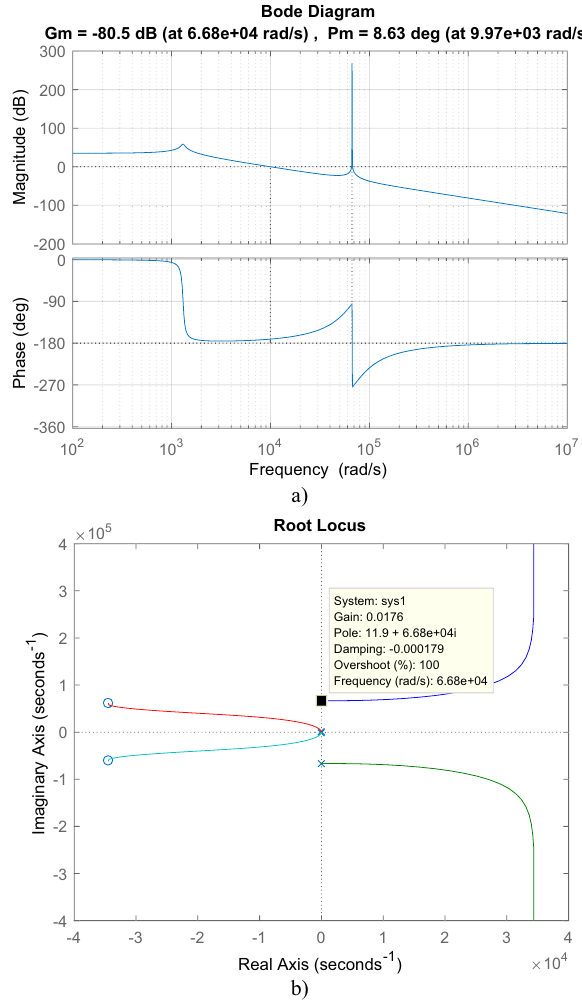
Figure 8. For isolated PFC Ćuk converter ( a ) Bode, ( b ) root locus